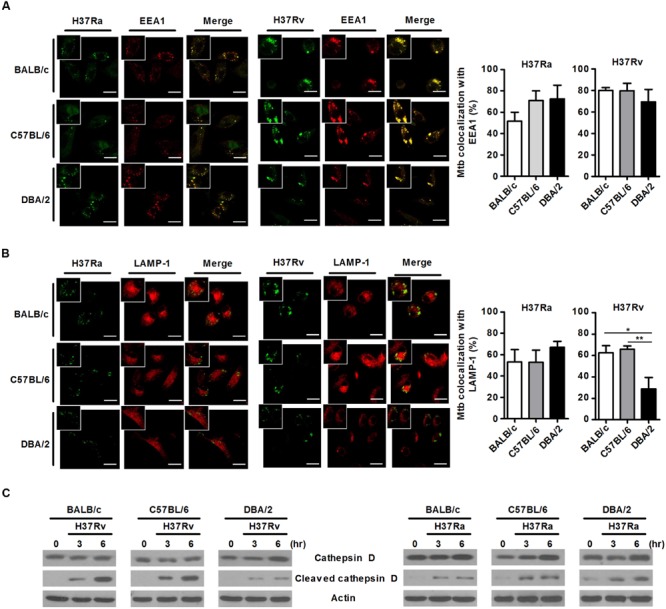
Virulent H37Rv arrests phagosome maturation in DBA/2 BMDMs. BMDMs that were isolated from BALB/c, C57BL/6, or DBA/2 mice were infected with virulent H37Rv or attenuated H37Ra for 4 h. After then, cells were fixed and stained with anti-CD107a LAMP-1-Alexa Fluor® 647 or anti-EEA1-Alexa Fluor® 647 antibodies. Co-localization between M. tuberculosis and EEA1 (A) or LAMP-1 (B) was determined using confocal microscopy. The bar graphs shows the percentage of the M. tuberculosis foci that co-localized with EEA1 (A, top panel) or LAMP-1 (B, bottom panel) in the quantitative analysis. The data are expressed as the mean value ± standard deviation of five independent experiments for each condition. Experiments were performed in triplicate. (C) Cleaved cathepsin D was detected in H37Rv-infected cells using Western blot assays. Significant differences are indicated by ∗P < 0.05; ∗∗P < 0.01.